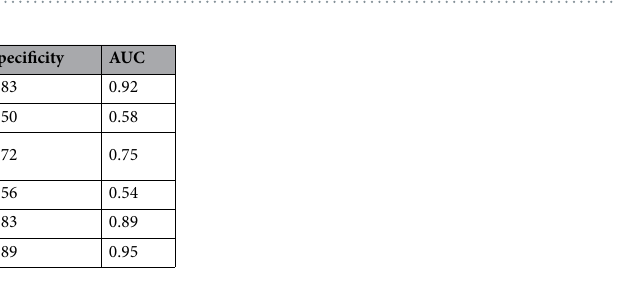
Table 1. Sensitivity and specificity calculated by ROC